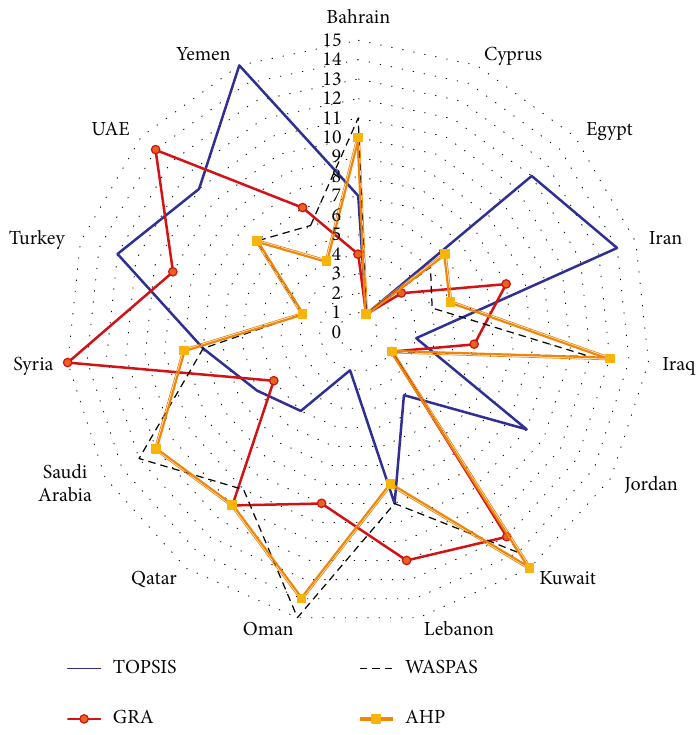
Figure 6: Results of ranking